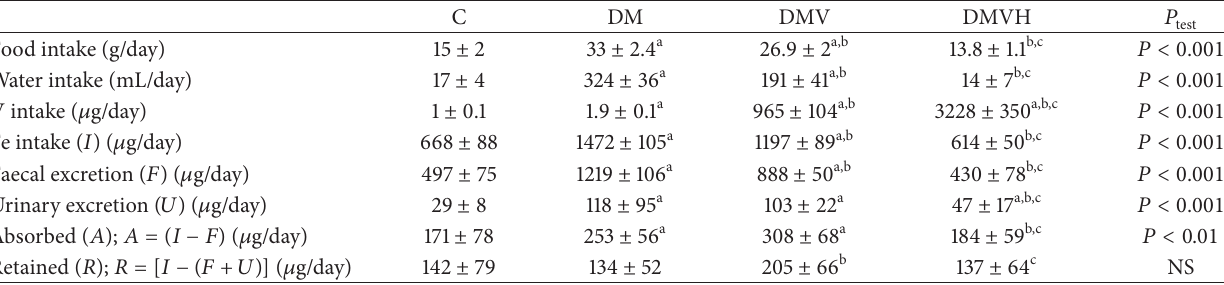
Table 1: Digestive and metabolic utilization of Fe on days 28–35 of